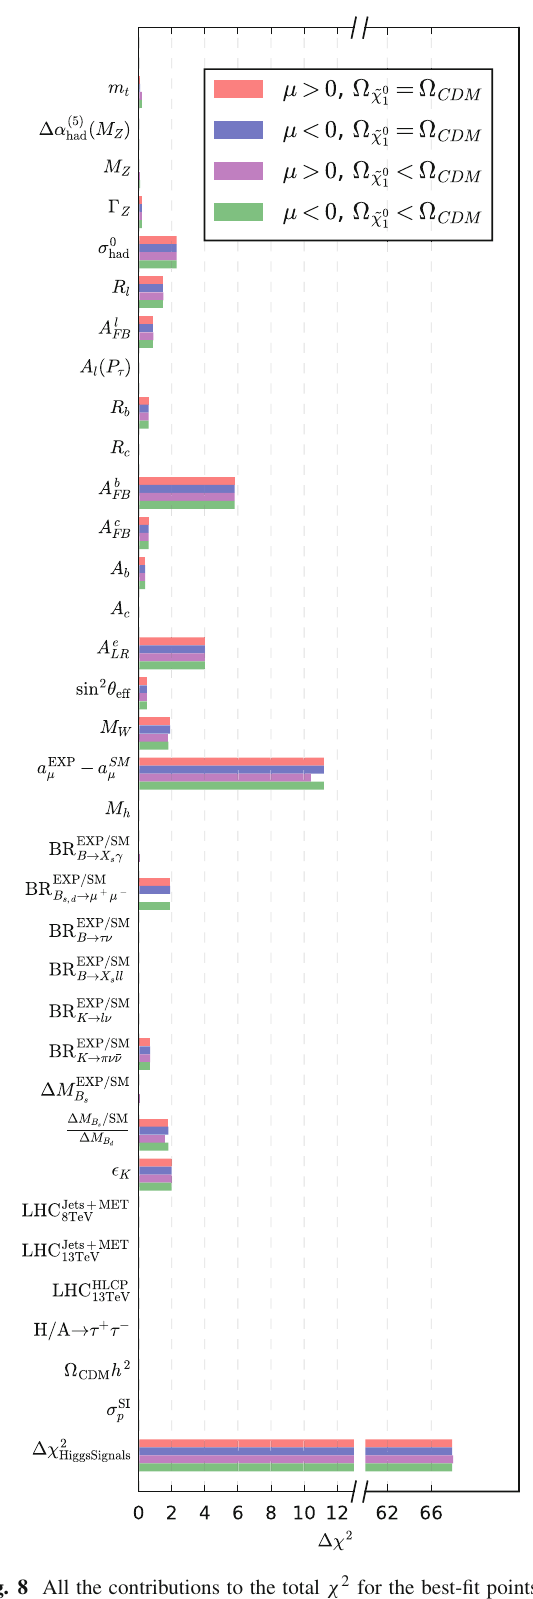
Fig. 8 All the contributions to the total χ 2 for the best-fit points for mAMSB assuming different hypotheses on the composition of the dark matter relic density and on the sign of μ as indicated in the